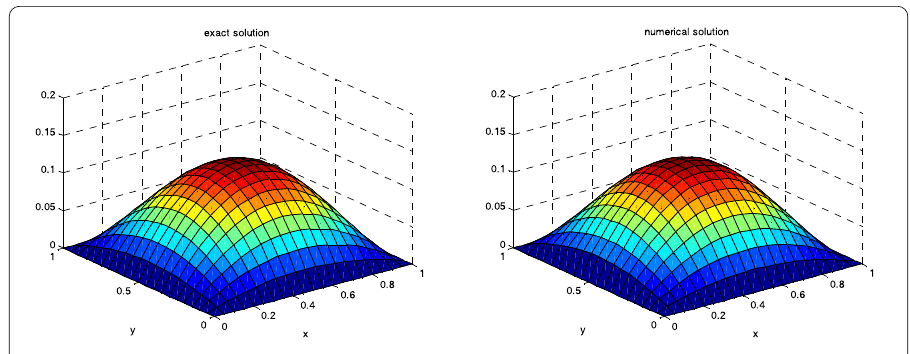
Figure 9 Comparison of numerical solution and exact solution when T = 1, (cid:11) t = 0.01, node number is 21 × 21